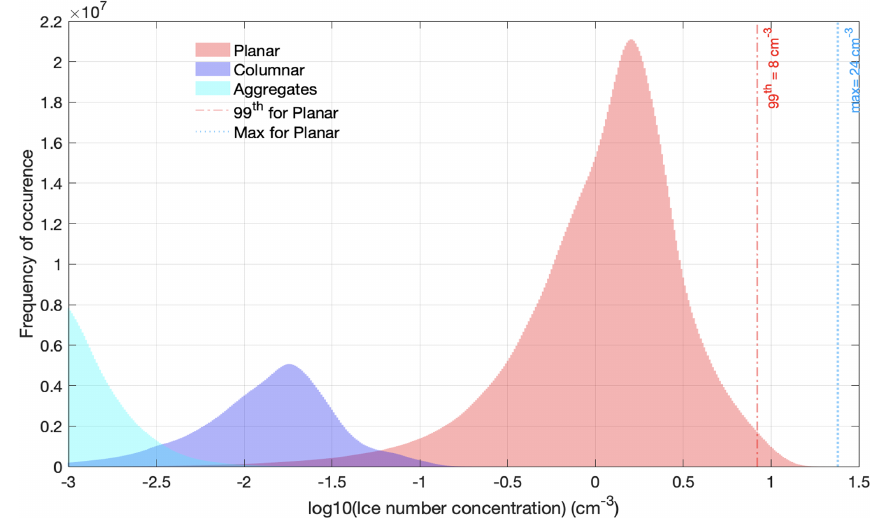
Figure 11. Distribution of ice number concentration on a log 10 scale using the ISHMAEL scheme for different ice habits: planar (red), columnar (blue), and aggregate (gray).